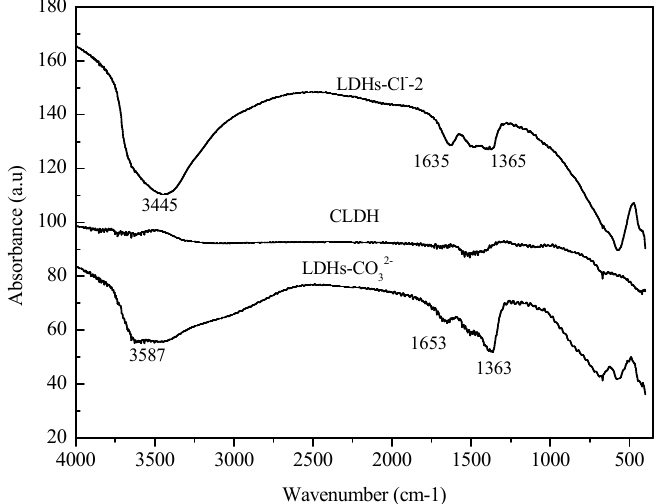
Figure 3. FTIR patterns of Mg − Fe − Ti − LDHs.